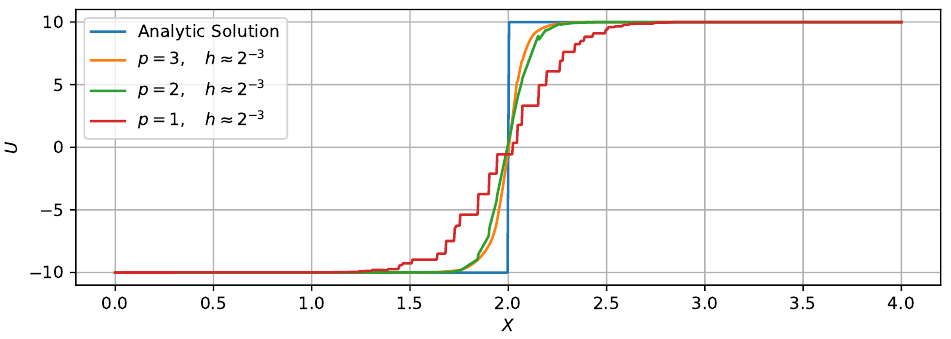
Figure 6. Comparison between solutions of Problem 1 given by running different solvers on the same mesh.